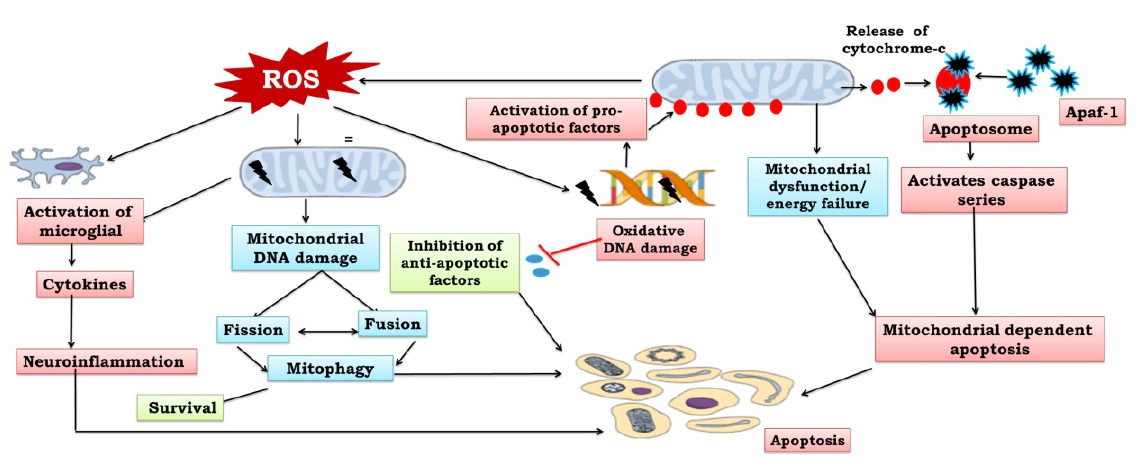
Figure 1. Mitochondrial apoptotic